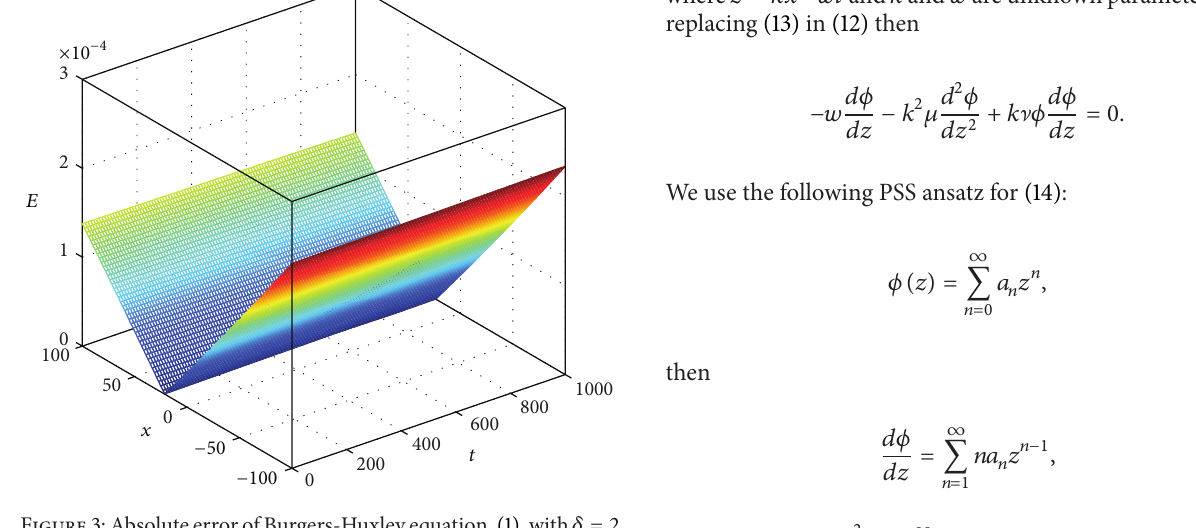
Figure 3: Absolute error of Burgers-Huxley equation, (1), with 𝛿 = 2 and 𝛾 = ] = 𝜂 = 0.001 .